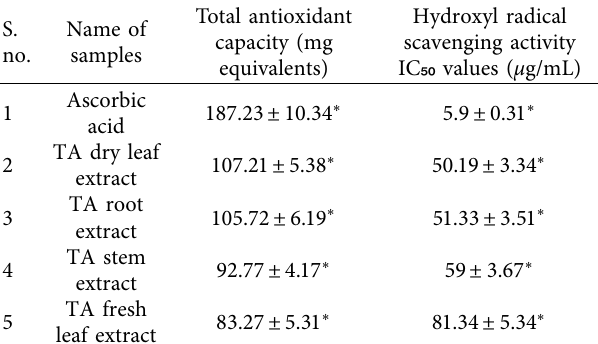
Figure 1: Total antioxidant capacity of all four parts (dry leaf, root, stem, and fresh leaf methanolic extract) of TA plant compared with standard compound ascorbic acid expressed in mg equivalents. Data represented as the mean ± SEM; n � 3 and ∗ p < 0 . 05. Table 3: Total antioxidant capacity and hydroxyl radical scav- enging activity of different parts of TA along with standard compound ascorbic